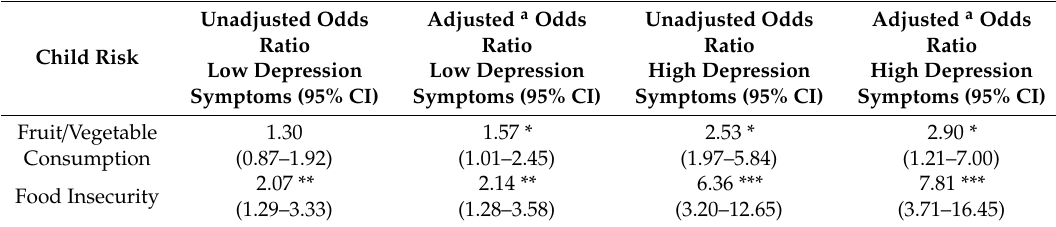
Table 3. Odds ratio for family food insecurity and inadequate child fruit / vegetable consumption in the home a by Maternal